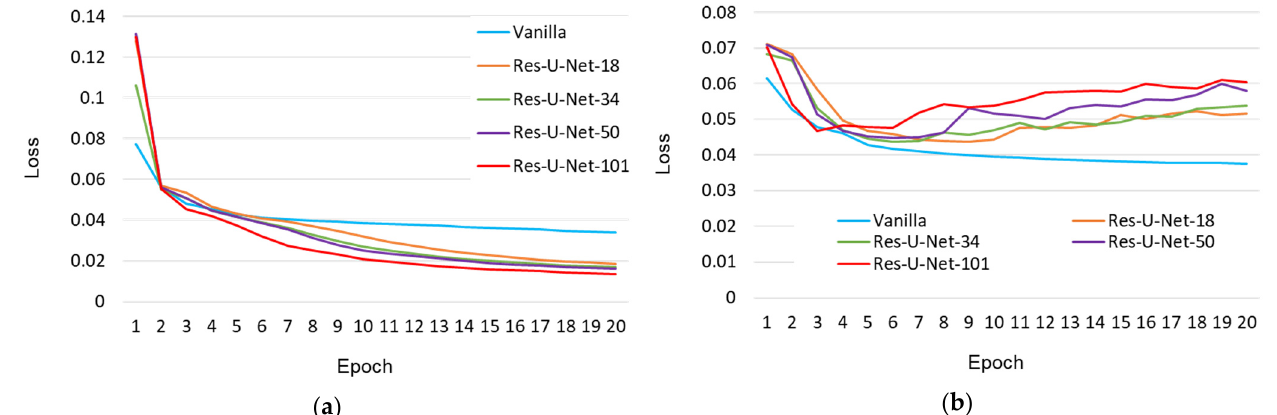
Figure 14. Per-epoch trend of losses: ( a ) training loss; ( b ) validation loss.